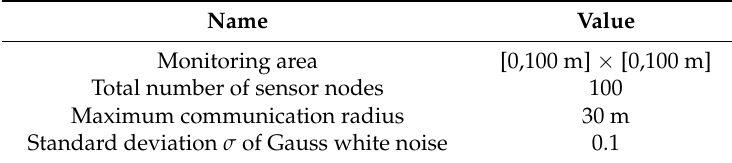
Table 3. Parameter table for influence analysis of anchor node